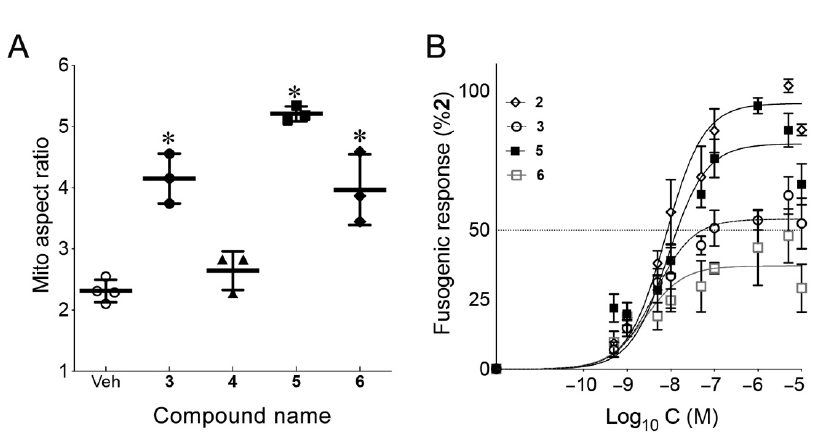
Figure 4. Piperidine analogs create a novel mitofusin activator scaffold.